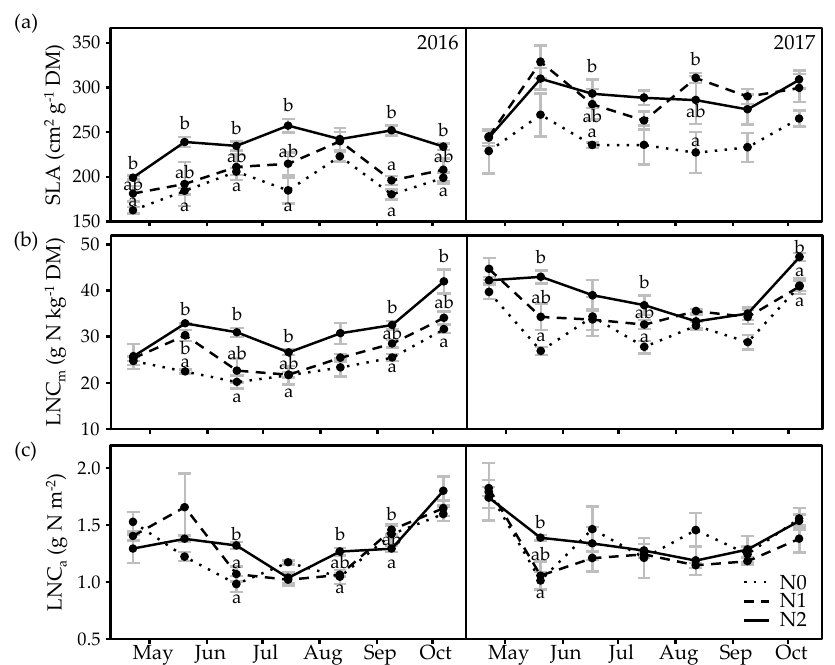
Figure 5. ( a ) Specific leaf area (SLA), ( b ) leaf nitrogen content per unit mass (LNC m ) and ( c ) leaf nitrogen content per unit area (LNC a ) during the vegetation period of 2016 and 2017 for three N application rates (0 (N0), 140 (N1) and 280 (N2) kg N ha − 1 ). Mean values at the same date with different superscripts differ between N application rates ( p ≤ 0.05). Error bars show the standard error of the mean for the interaction between defoliation date and N application rate.